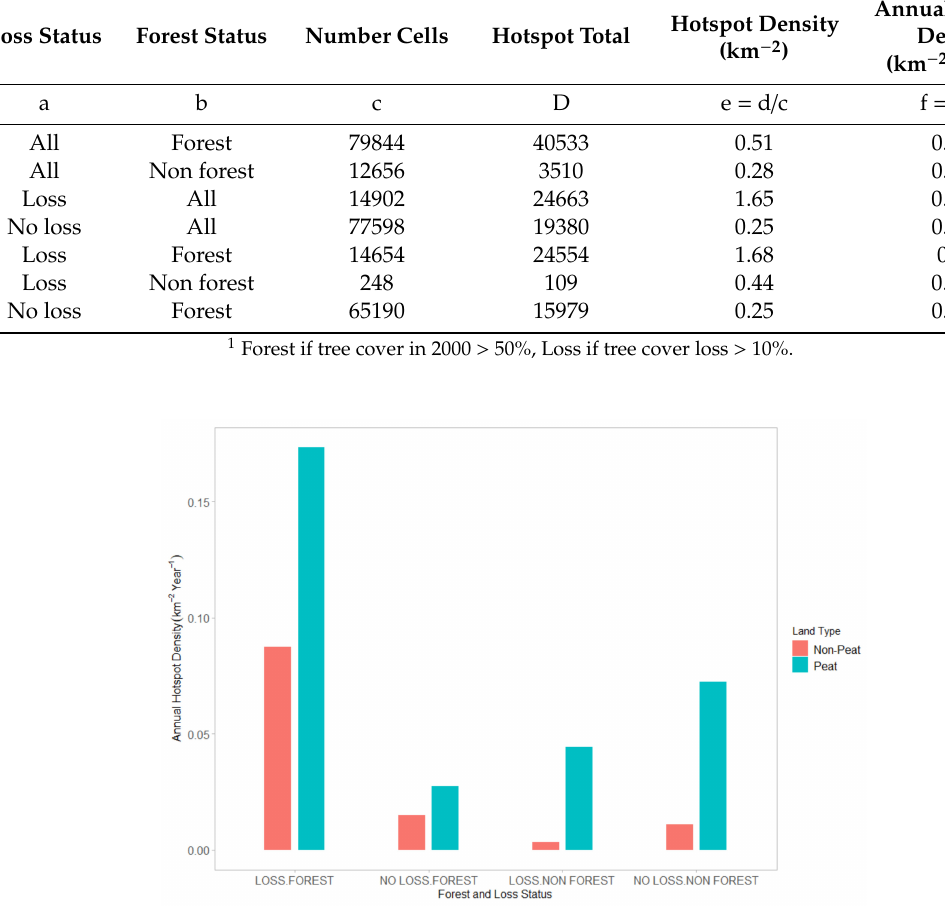
Figure 4. Annual hotspot density according to forest cover and forest loss status. Forest is defined as areas which have a tree cover in 2000 > 50%; areas of forest loss are defined as areas with tree cover loss >